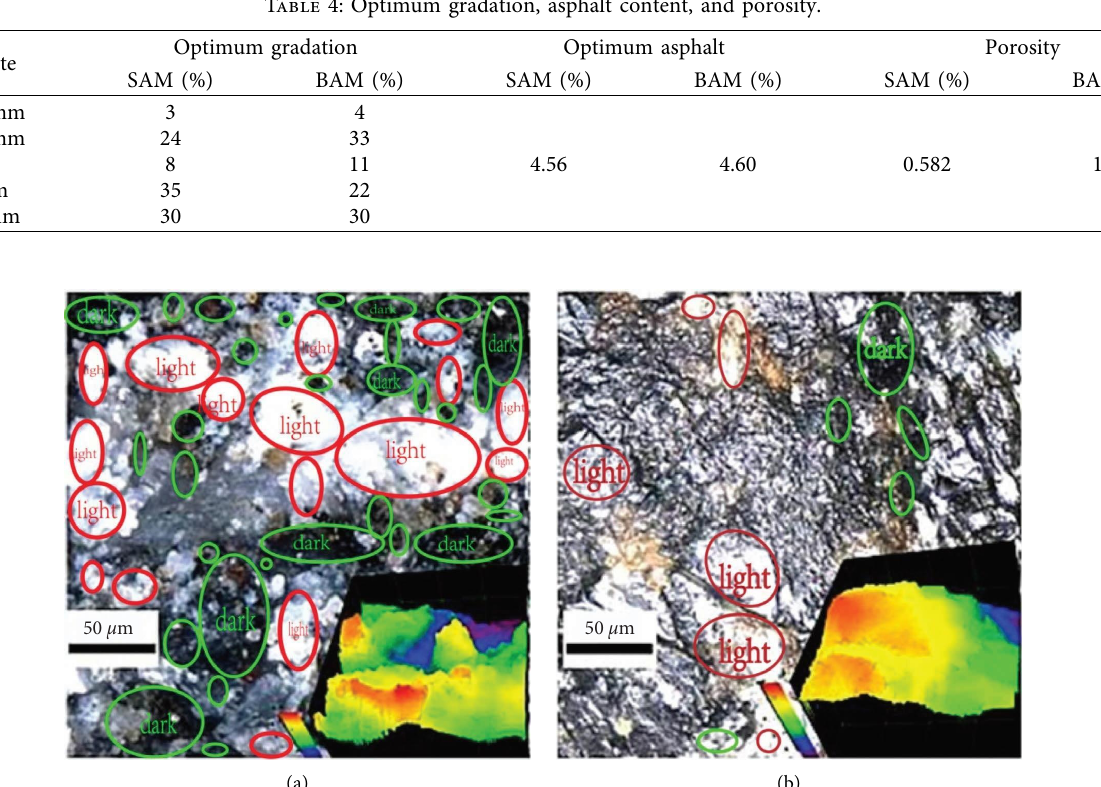
Figure 1: Mesosurface topography of aggregates: (a) mesosurface topography of steel slag; (b) mesosurface topography of